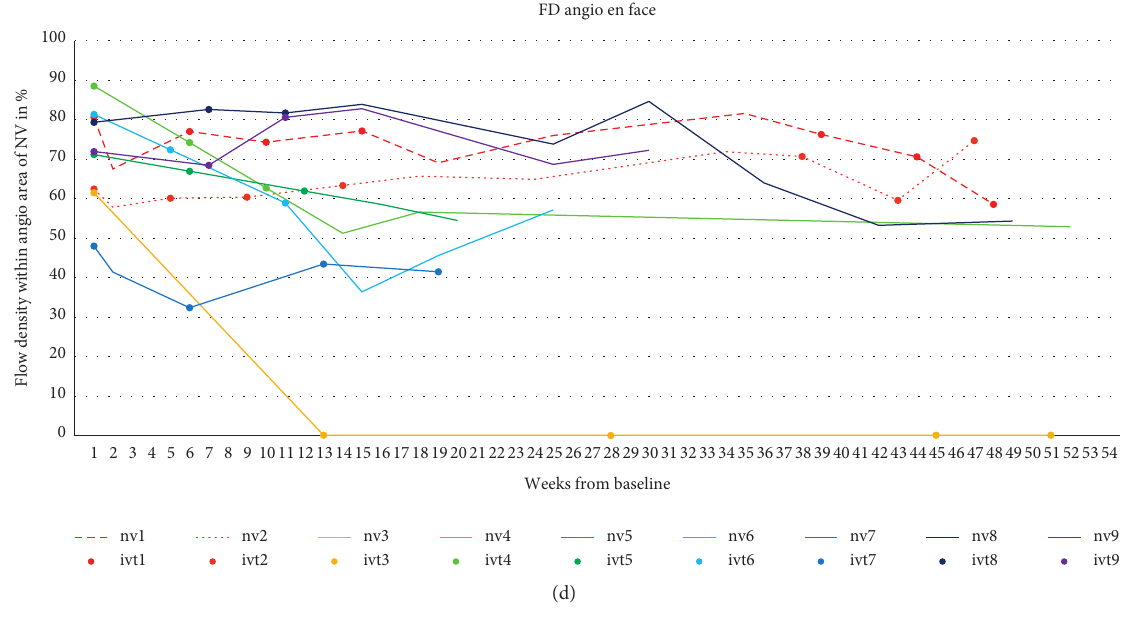
Figure 3: (a–d) Visualizing changes of area size and flow density of neovascularization (NV) for the flow and the angio area for every NV separately (data series NV 1–9). Bullet points represent time points of antivascular endothelial growth factor (anti-VEGF) injections in the respective eyes (data series IVT 1–9). It is indicated that in en face imaging, the structural framework (NV-structure) is at least partly remaining despite the fact that perfusion area (NV-angio) and flow density within the structural area (FD-structure) are regressing, while flow density within the angio area (FD-angio) is relatively stable. The two NV from the case presentation (NV 1 with vitreous hemorrhage and NV 2) are represented in dotted lines for better recognition. (a) Relative change of NV-structure from baseline ( � 1). The graph shows that the structural areas of the NV decrease only slightly. (b) Relative change of NV-angio from baseline ( � 1). The graph shows that in most NV, the angio area en face is decreasing after treatment with anti-VEGF. Two NV are growing back to a significant proportion after a long treatment-free interval. In one of these eyes, a new vitreous hemorrhage occurred before retreatment. (c) Flow density within the structural NV-area (FD-structure) in %. The graph indicates the consistent decrease of flow density within the structural areas of the NVs after treatment, as well as a new increase of the two NVs with recurrent proliferative diabetic retinopathy (PDR) activity. (d) Flow density within the angio NV-area (FD-angio) in %. The graph indicates the lesser decrease of flow density within the structural areas of the NVs after treatment. Also, in the case of the two NVs with recurrent PDR activity, it cannot be determined by the flow density of the NV measured on the OCTA angio